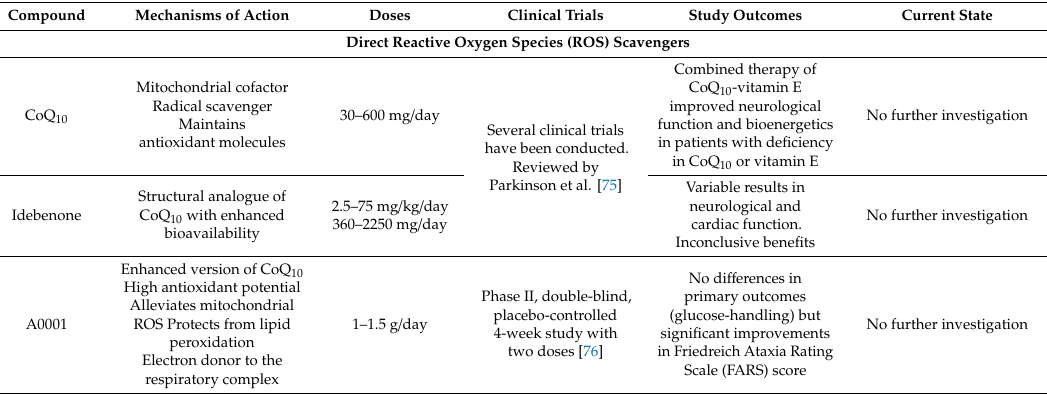
Table 1. Summary of clinical trials carried out and ongoing in FRDA patients with compounds that target oxidative stress at di ff erent levels. Trials have been grouped according to the mechanism of action of the drug tested. To facilitate comparison, table also includes the range of doses used, the corresponding phase of each trial, its result when available and the present or future prospect of the treatment. (CoQ 10 : Coenzyme Q 10 ). The clinicaltrial.gov reference numbers for trials that are currently ongoing have been